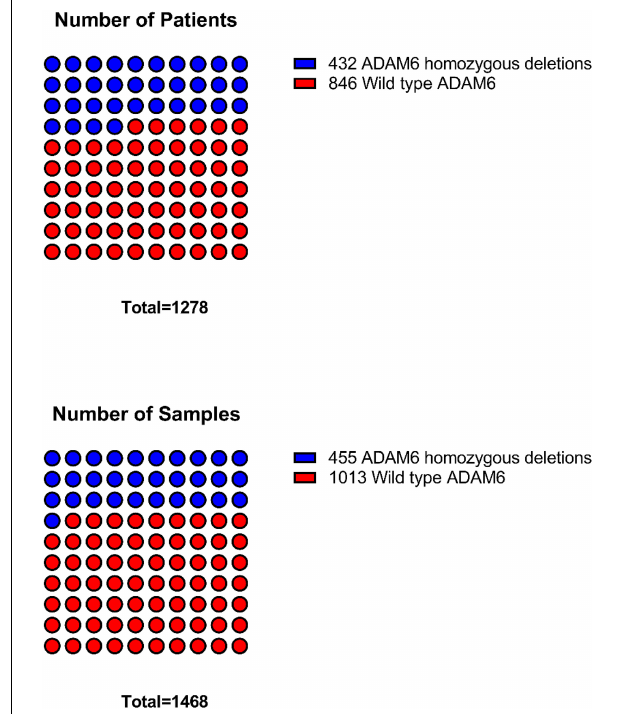
FIGURE 2 | Distribution of samples and patients with ADAM6 homozygous deletions compared to the rest with wild-type ADAM6.